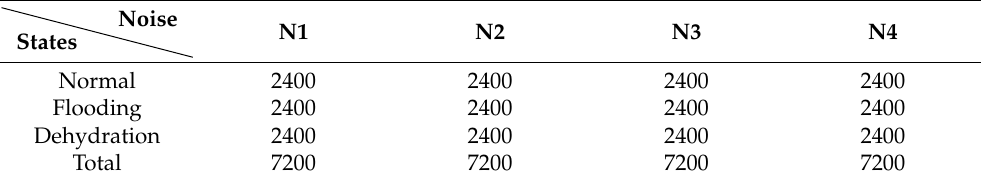
Table 3. Details of data enhancement for different PEMFC